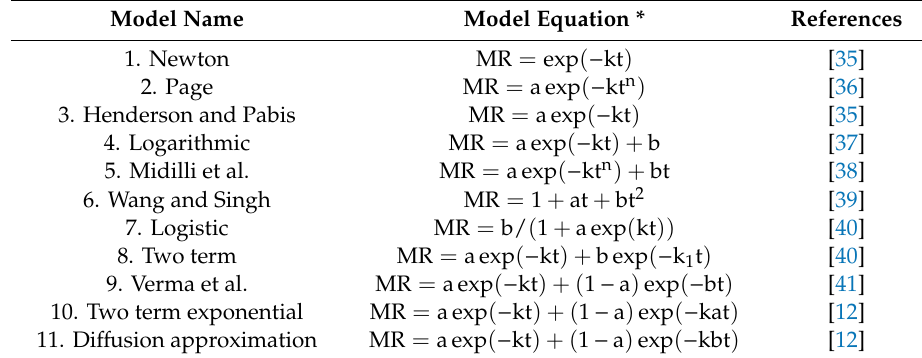
Table 2. Mathematical models for the drying curves of organic and conventional red peppers used in the